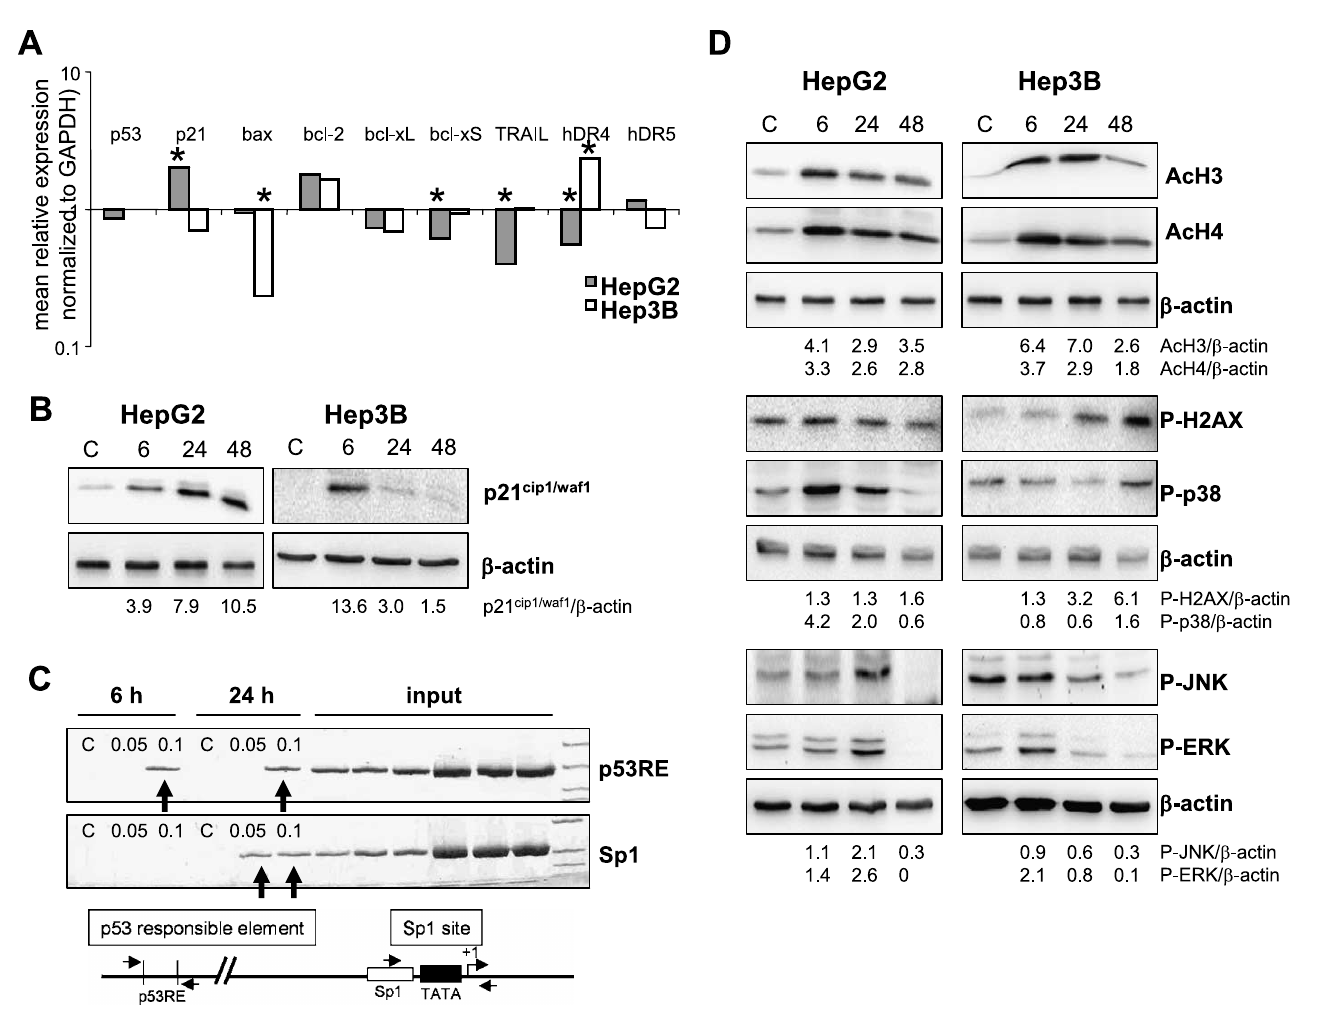
Fig. 3. Differential regulation of signal transduction pathways. (A) Quantitative real-time RT-PCR analysis after 48 h treatment with 0.1 µM panobinostat. mRNA expression was normalized to GAPDH and results are expressed relative to untreated controls set at 1.0. * P < 0 . 05 vs. control. p53 was not detectable in Hep3B. (B) Western blot analysis of p21 cip1/waf1 expression in HepG2 and Hep3B. (C) Chromatin immunoprecipitation (ChIP) of the p21 cip1/waf1 promoter in HepG2 cells showing a binding of the p53-responsive element (p53RE) already after 6 h and a subsequent transactivation of the Sp1 binding site after 24 h (arrows). (D) Western blot results for further signaling molecules after incubation with 0.1 µM panobinostat. Densitometry results were normalized to β -actin content and are expressed relative to untreated controls set at